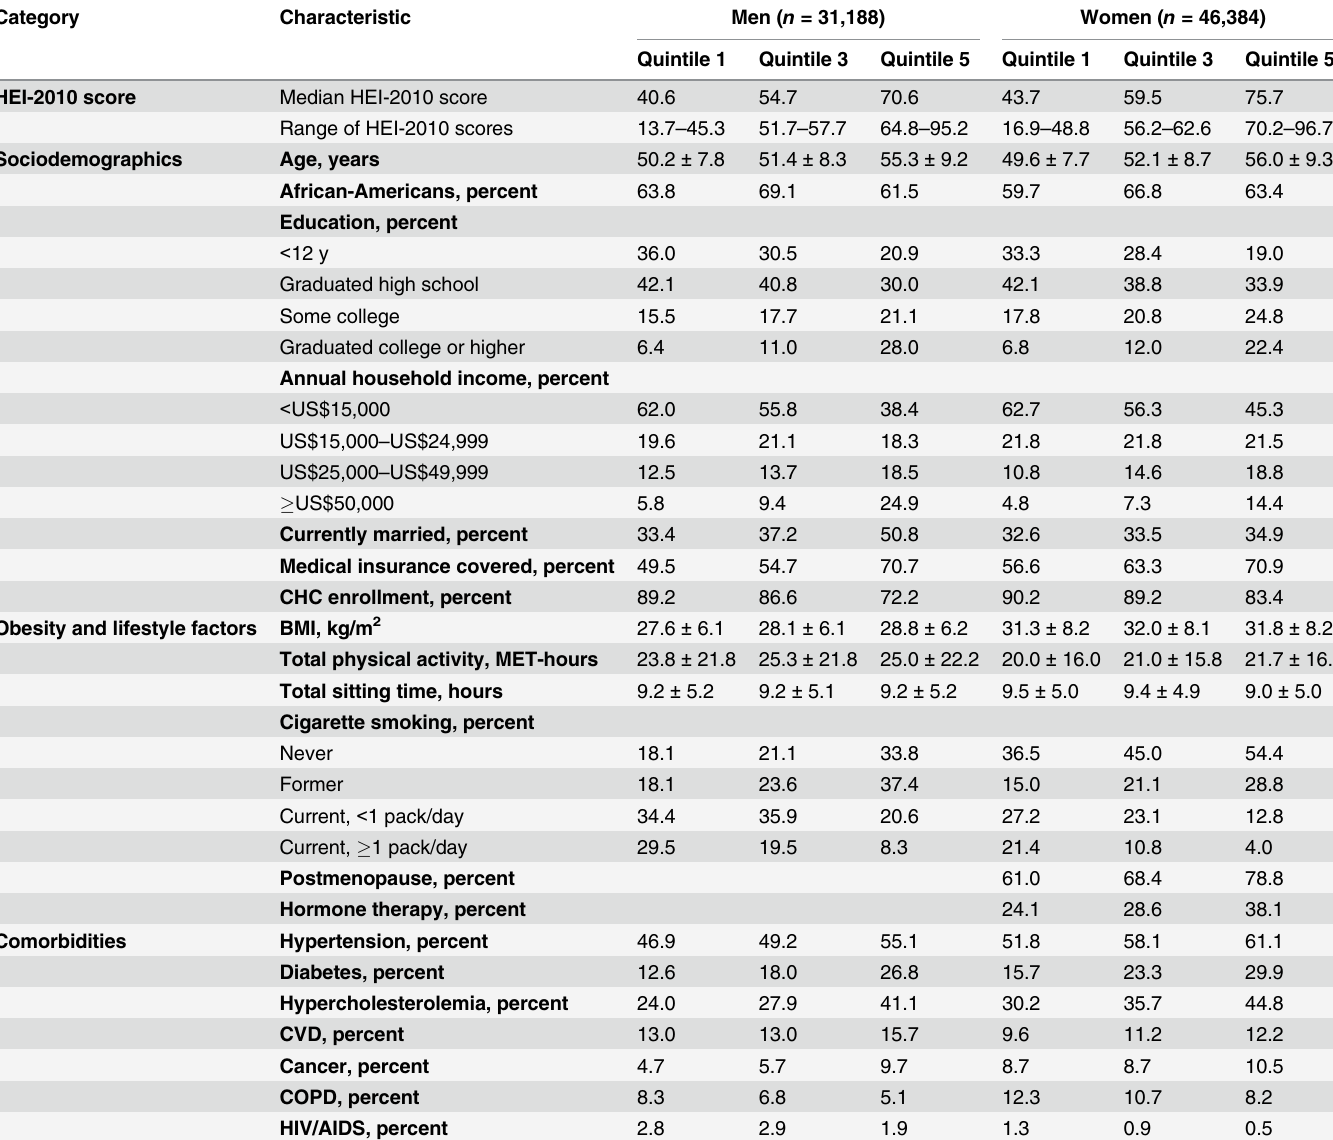
Table 1. Baseline characteristics by sex-specific quintiles of HEI-2010 scores in the Southern Community Cohort Study, 2002 – 2009.